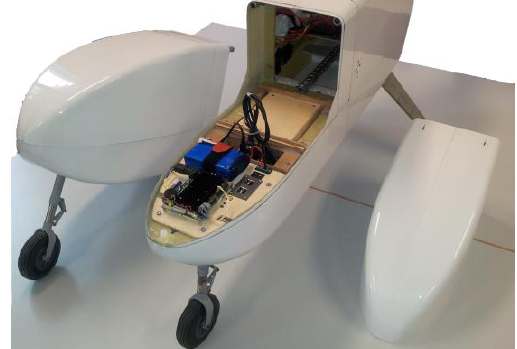
Figure 8. Modular Payload